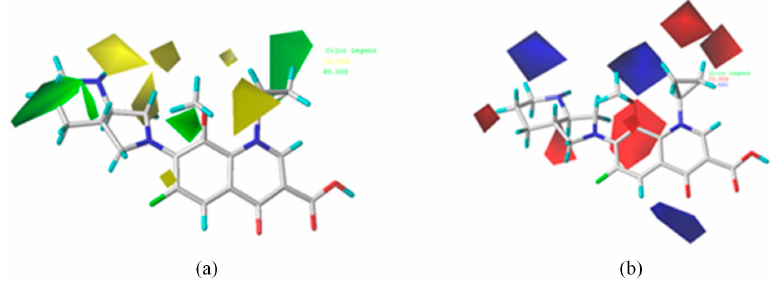
Figure 3. Contour maps of CoMFA model, ( a ) steric field, ( b ) electrostatic field. In the steric field, green contours showed that bulky groups increased the combined biodegradability of FQs, while yellow contours showed that bulky groups decreased the combined biodegradability of FQs. In the electrostatic field, blue contours showed that positive charges increased the combined biodegradabil- ity of FQs, and red contours showed that negative charges decreased the combined biodegradability of